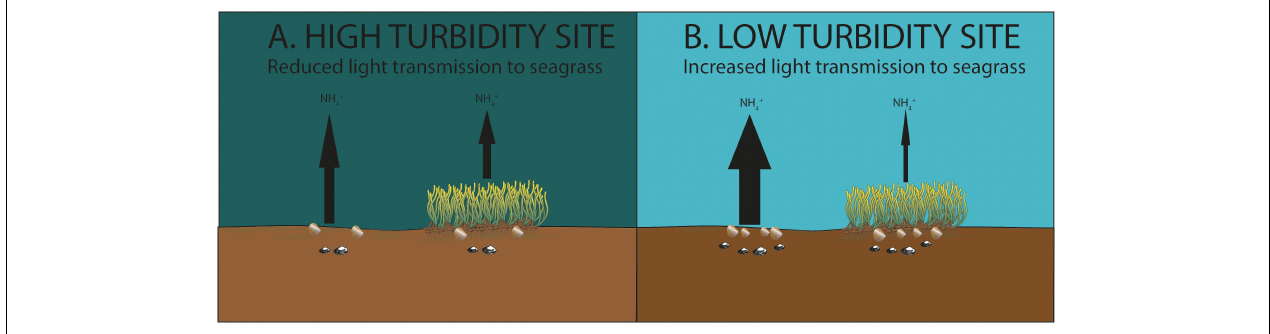
FIGURE 4 | (A) Lower organic matter and bivalve abundance, higher chlorophyll a content (Site Mai C). (B) Higher organic matter and bivalve abundance, lower chlorophyll a content (Site TPB). At bare sediment sites higher sediment-water column efflux of inorganic nutrients (NH 4 + ) was observed due to higher organic matter content, bivalve abundance, and lower chlorophyll a content. Despite these factors, lower inorganic nutrient efflux was observed at the seagrass sites exposed to lower turbidity, indicating higher nutrient removal by seagrass exposed to lower turbidity.